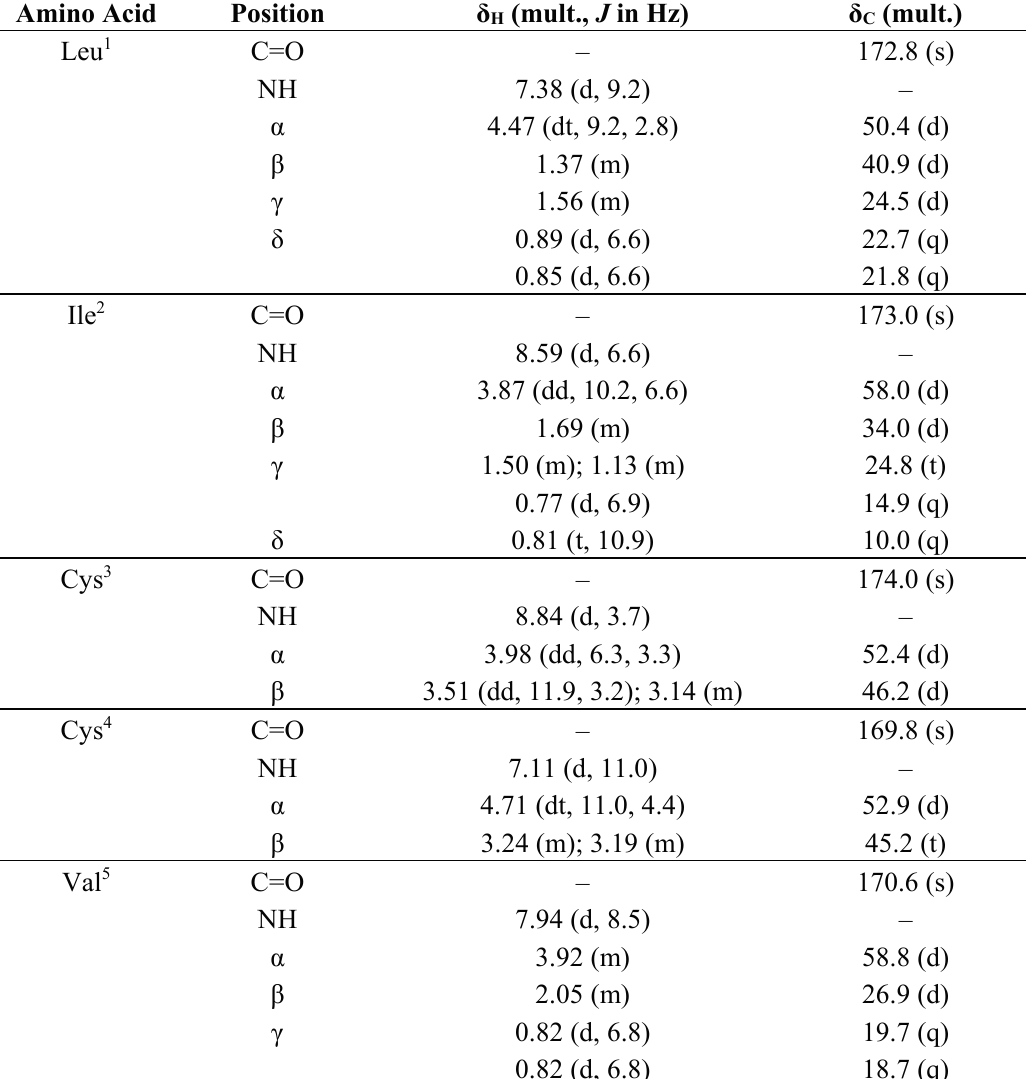
Table 1. NMR data of malformin A 1 ( 1